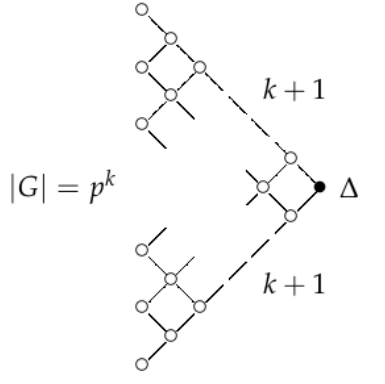
Figure 3. The weak congruence lattice of the cyclic group of order p k . Next, we characterize several classes of simple